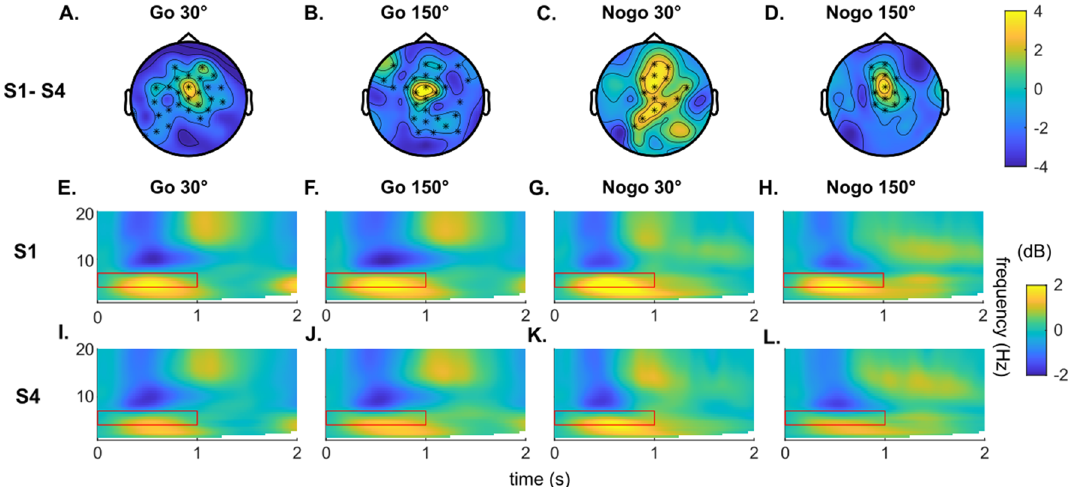
Figure 3. Time–frequency analysis results. ( A – D ) illustrate the difference in baseline-corrected theta power (in dB) between S1 and session S4. Each asterisk in the scalp topography plots denotes significant results in the cluster-based permutation test ( p < .05). The color bar indicated the t -values. ( E – L ) show the time–frequency plots. The red rectangles mark theta activities (4 ~ 7 Hz) in the time interval of 0 to 1